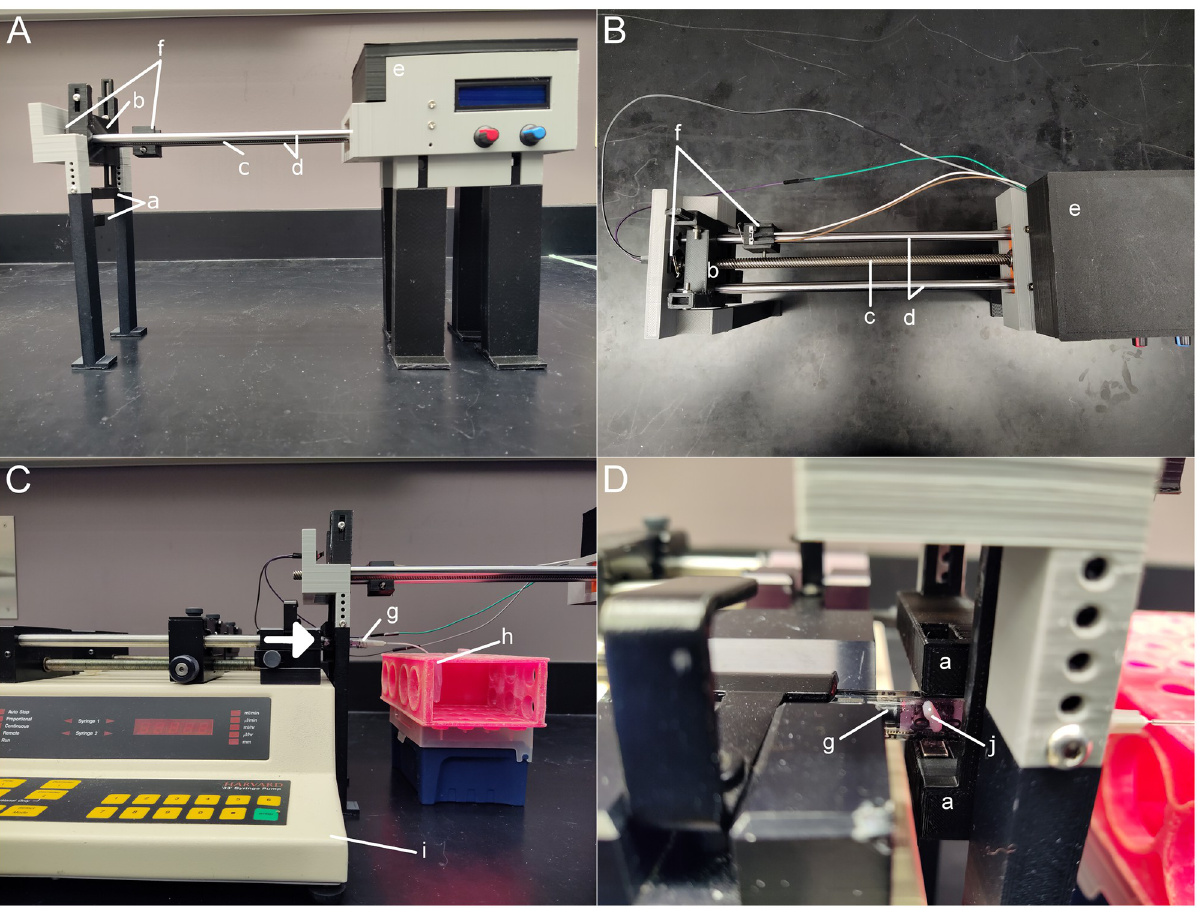
Fig 1. The automated agitation device to maintain colloidal suspension during syringe pump perfusion. Front (A) and top (B) views without a syringe pump. The device alongside a syringe pump from the front (C) with an arrow indicating perfusion direction and a closeup, transverse view of the syringe (D). Labeled components include the hooked attachments with mounted neodymium magnets (a), the lead screw assembly (b), the lead screw (c), guide rods (d), the controller housing (e) containing the DC motor, joint coupler, microcontroller, motor controller, potentiometers, push buttons, and liquid crystal display, the end-stop limit switches (f), a syringe (g), a collection Eppendorf tube (h), a syringe pump (i), and the magnetic stir bar